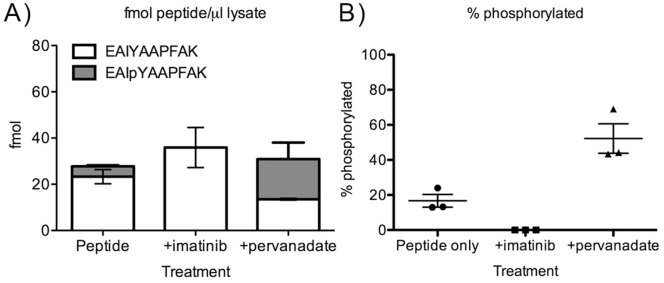
Quantification of peptide amounts and percent phosphorylation.Total peptide detected is represented by each full bar in (A), with the white portion representing the fraction of phosphopeptide and the gray fraction representing the fraction of unphosphorylated peptide. % phosphorylation is shown in (B). Error bars in both represent SEM from three replicate biological experiments.